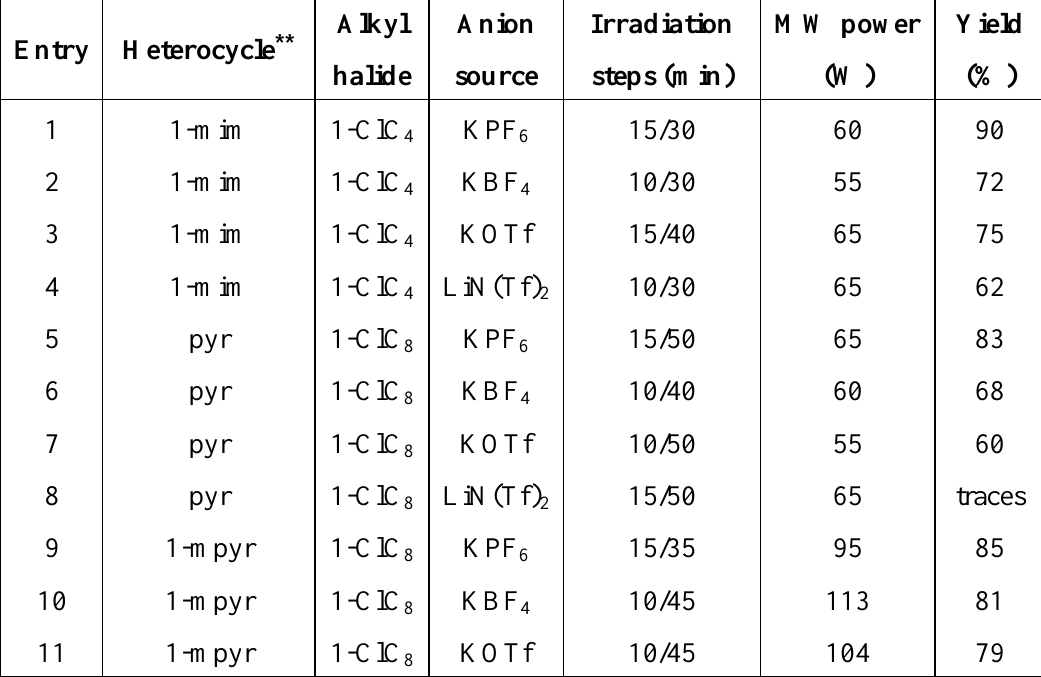
Table 3 . MW-assisted one-pot RTIL synthesis (closed